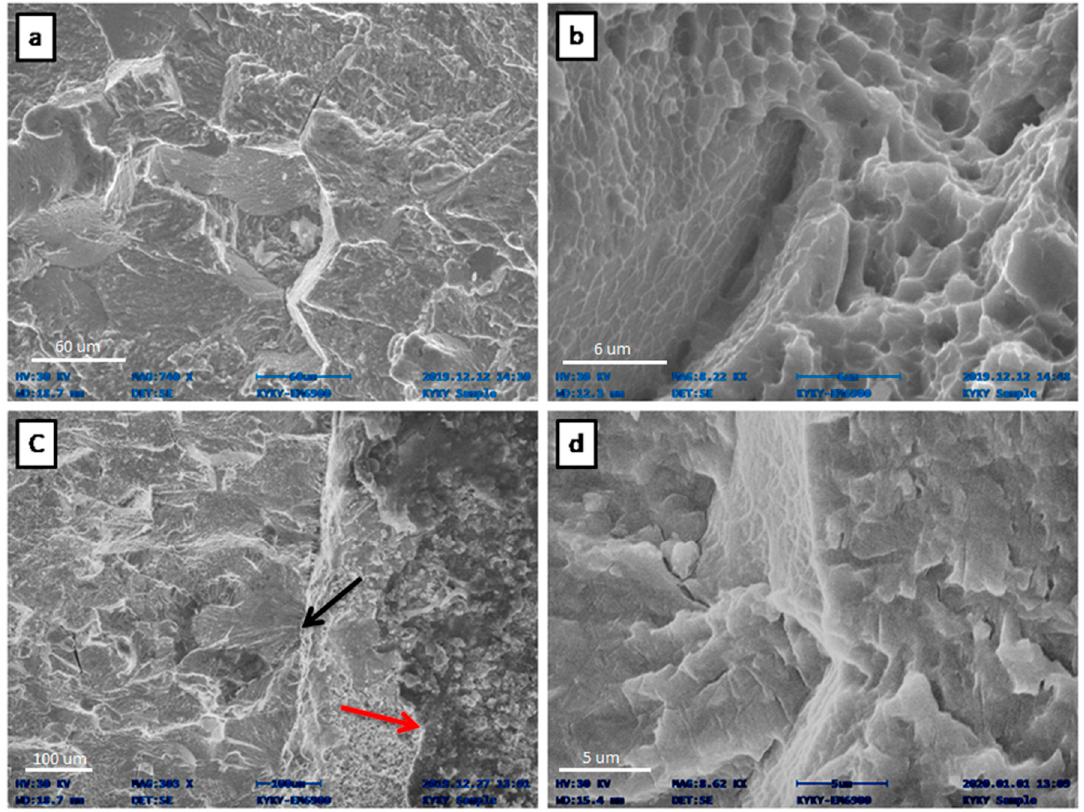
Figure 8. SEM fracture surface micrograph of Ti-27Nb specimen placed in human body fluids ( a , b ) for 504 hrs. and ( c , d ) for 816